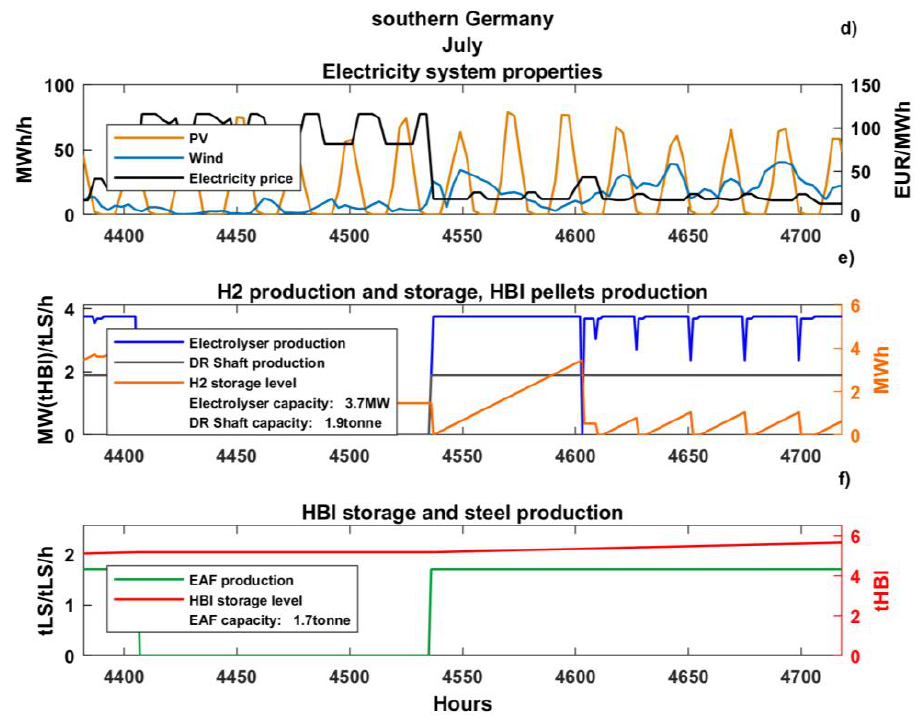
Figure 6. Levels of generation of PV and wind power (MWh/h) and electricity price profiles (EUR/MWh) ( a , d ); production levels of the electrolyser and DR shaft furnace (MW(tHBI)/tLS/h), and state of charge of the hydrogen storage (MWh) ( b , e ); production levels of the EAF (tLS/tLS/h) and state of charge of the HBI storage (tHBI) ( c , f ), in southern Germany for 2 weeks in March (upper plots) and in July (lower plots) in the year 2050.